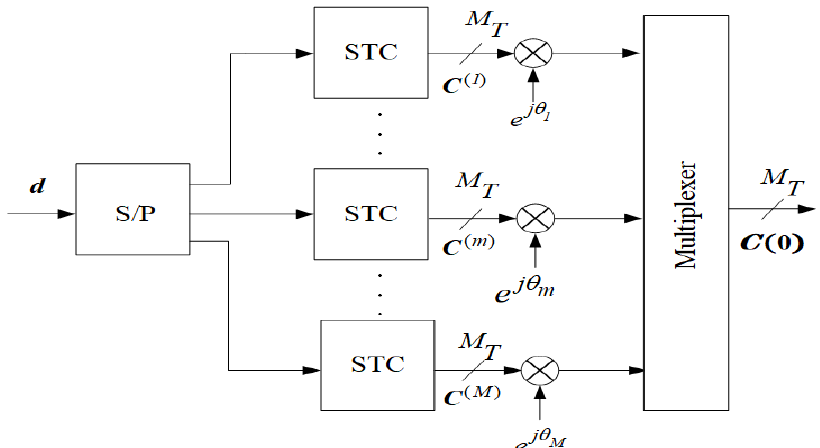
Figure 1. Proposed